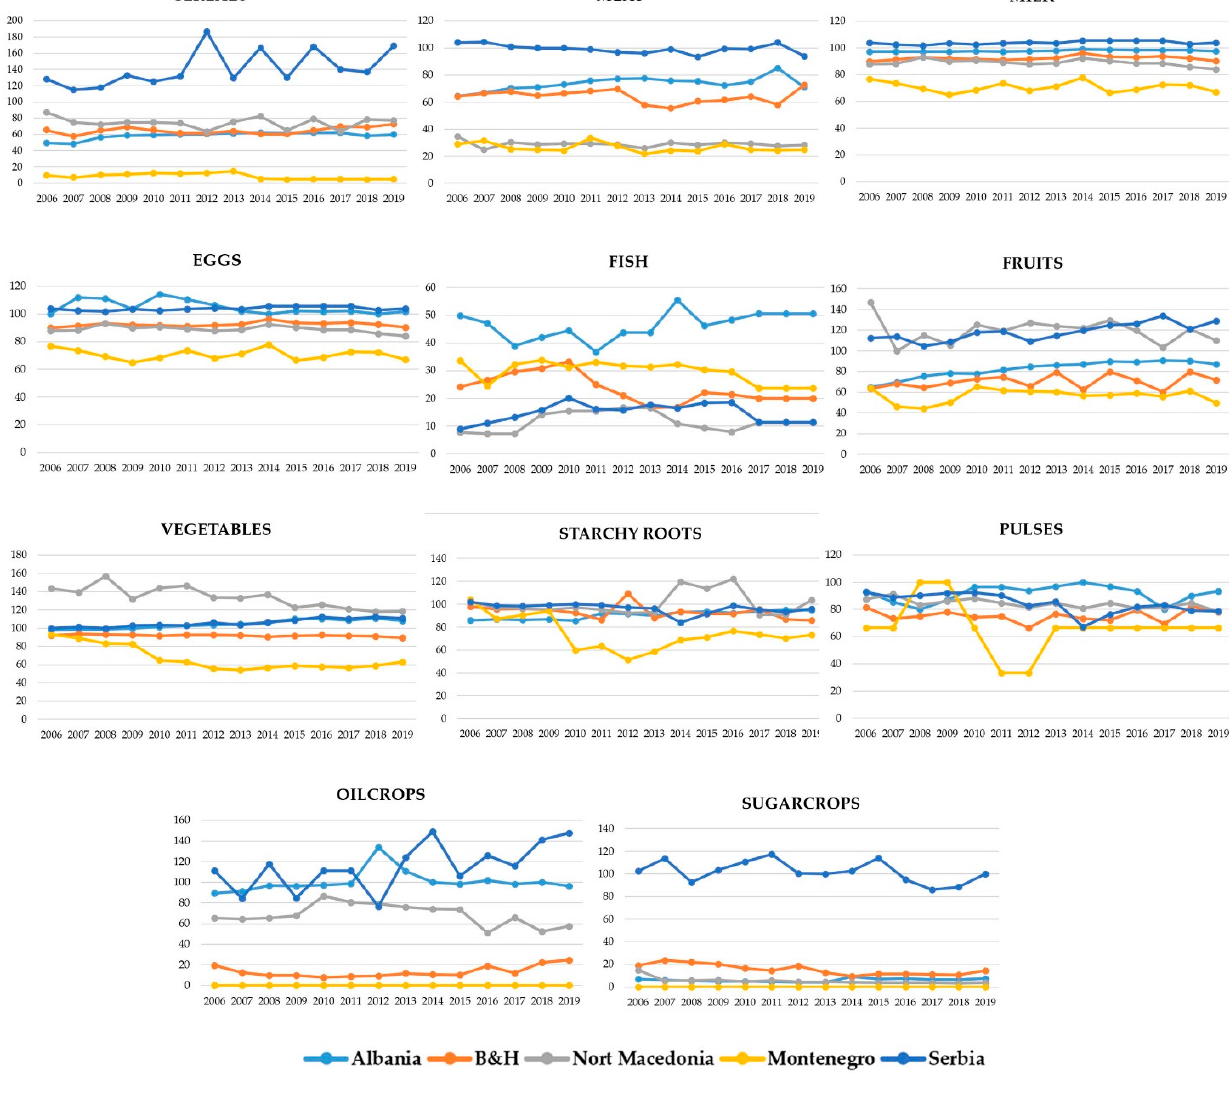
Figure 2. Self-sufficiency ratio based on FAOSTAT. Source. The authors’ calculation.